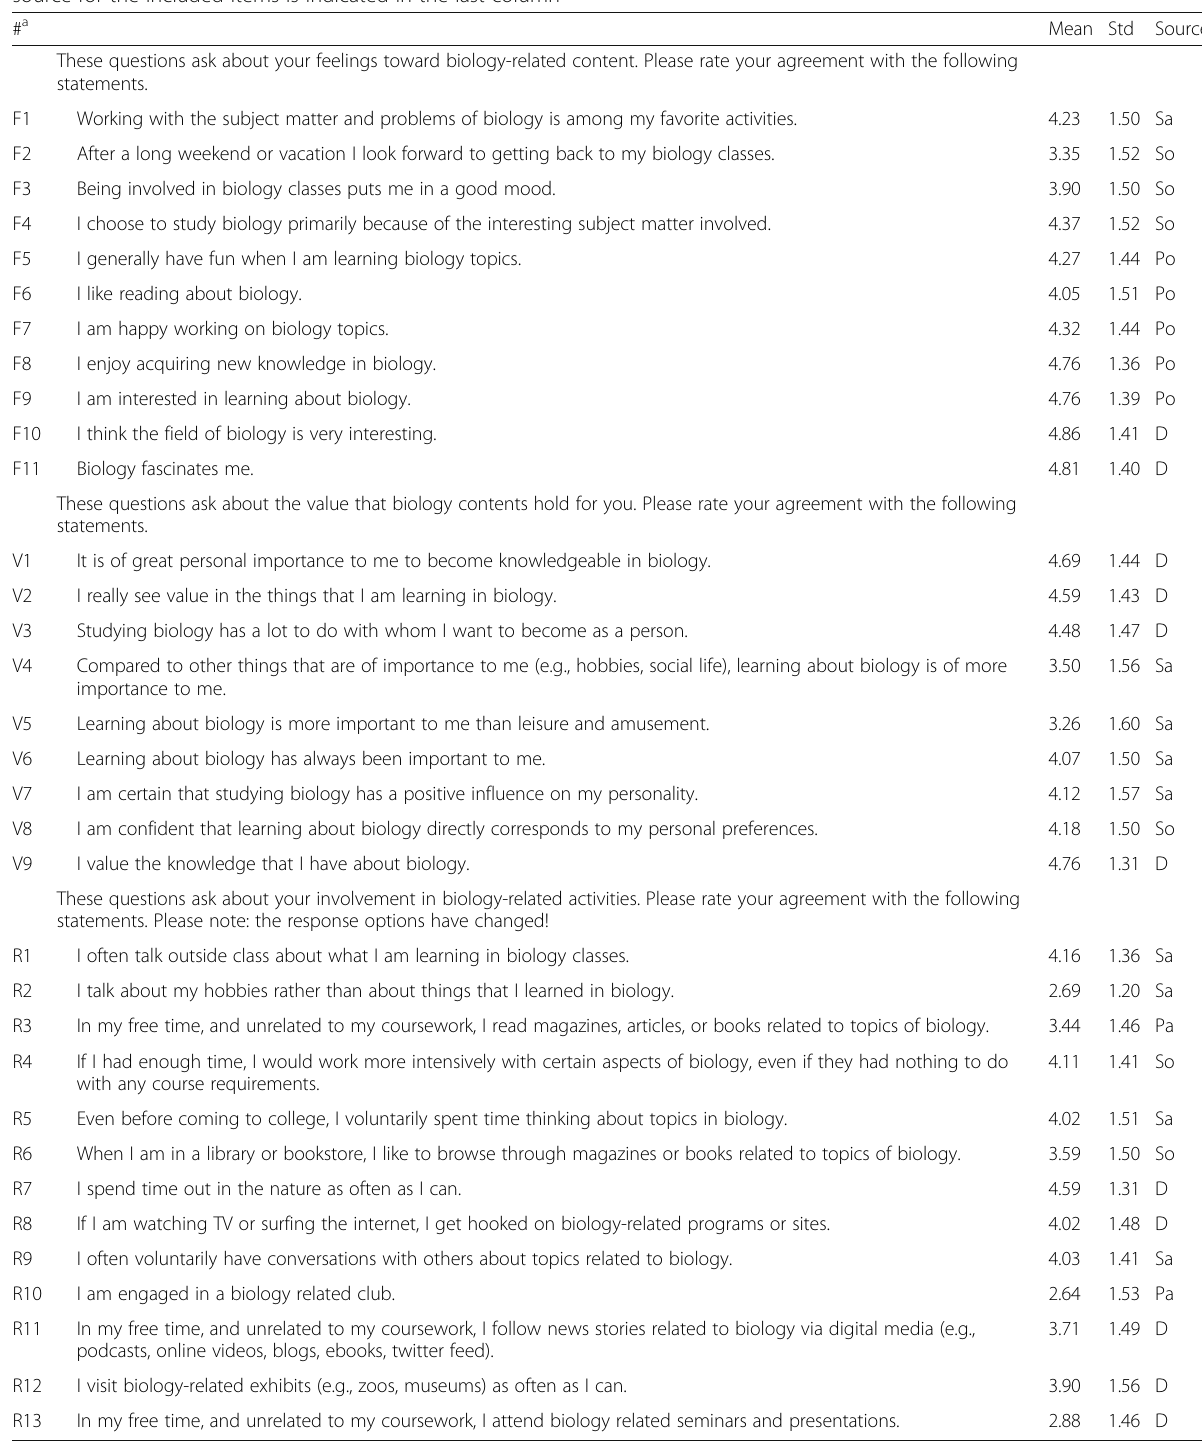
Table 1 Items included in the original scale. Mean values and standard deviations for the biology major group are given. Original source for the included items is indicated in the last column #